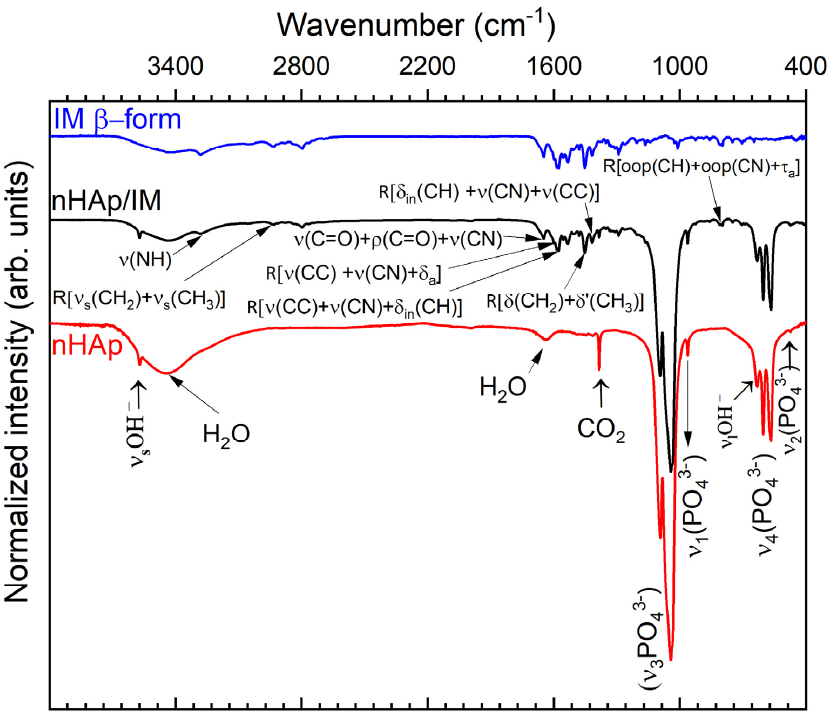
Figure 3. FT-IR spectra of imatinib (IM β -form, blue line), nanohydroxyapatite (nHAp, red line), and nHAp / IM (black line) with the indication of characteristic vibration bands for both compounds. Types of vibration: ν , stretching; δ , deformation (bending); oop, out-of-plane bending; ρ , rocking; τ ,